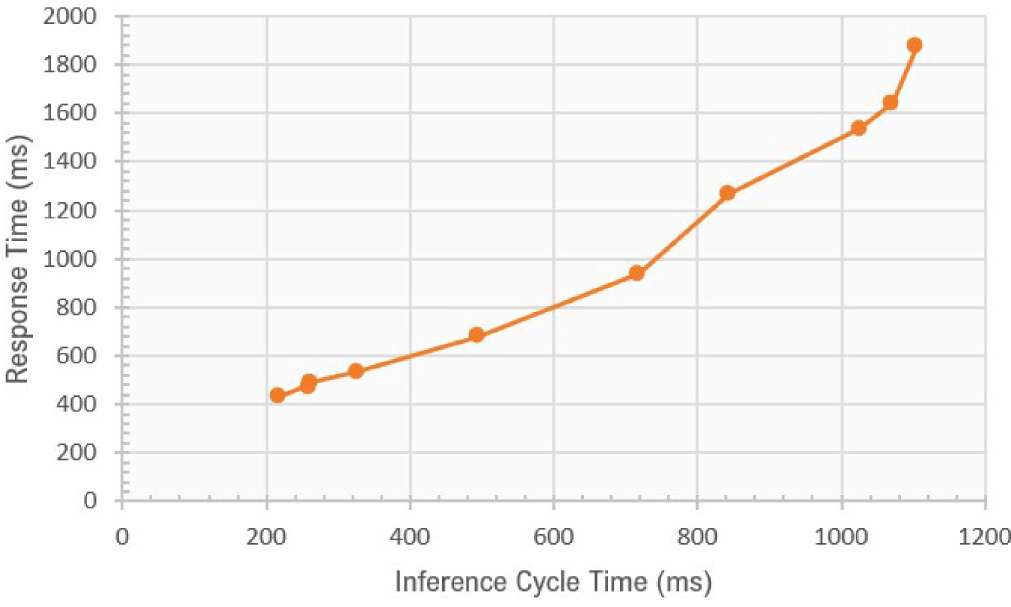
Figure 16. Correlation between inference cycle time and response time.